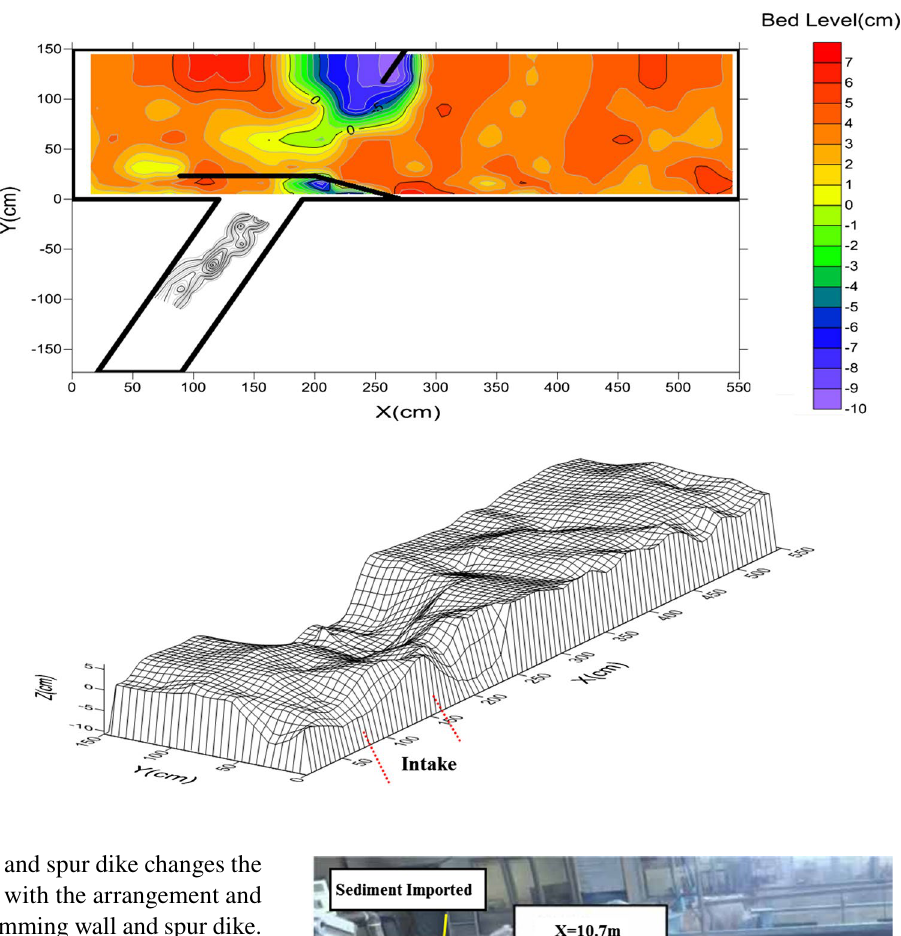
Fig. 8 Bed topography in the main channel with skim- ming wall and spur dike ( Q = 0.06 m 3 /s)